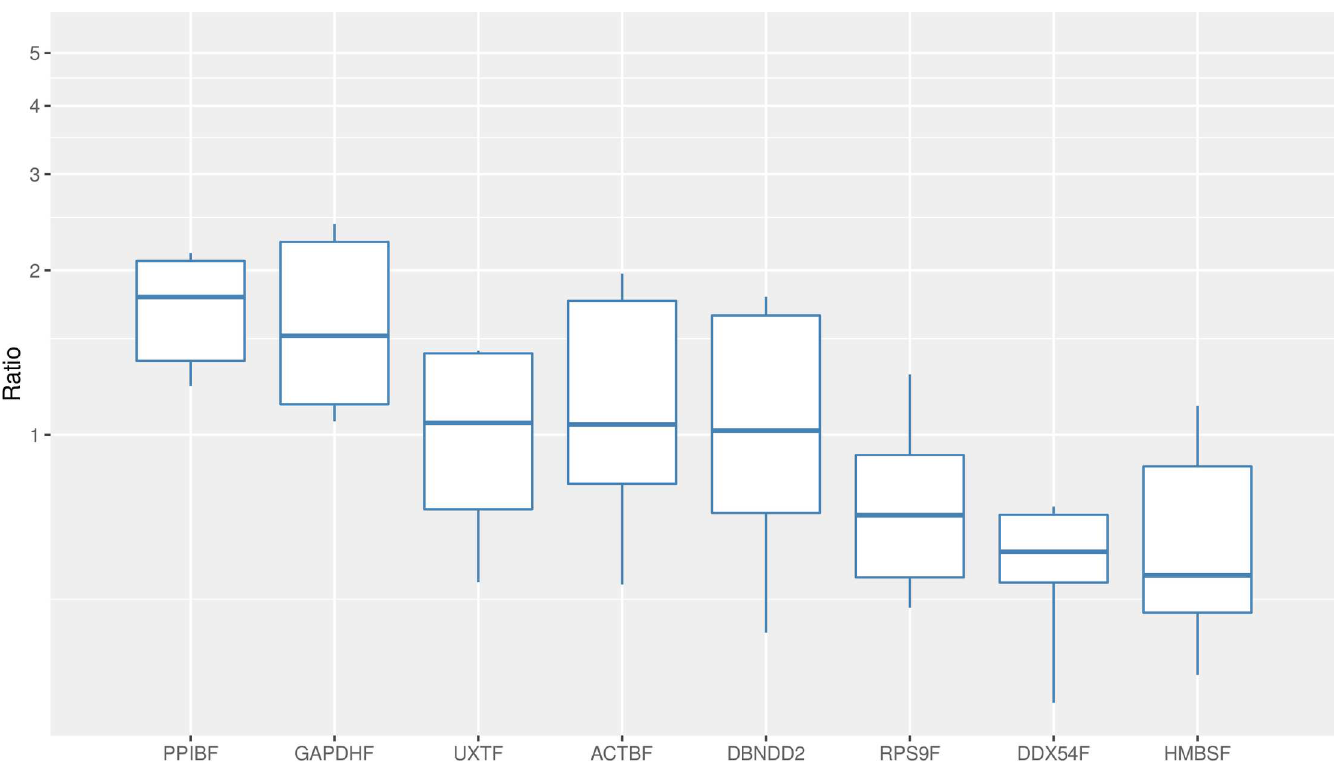
Fig 5. Normalization of RCC2 mRNA expression at 0 and 14 days after butyrate infusion using 1 single referencegene. The X-axis shows the internalgenethat was used for estimatingeach ratio. Y-axis is shown in